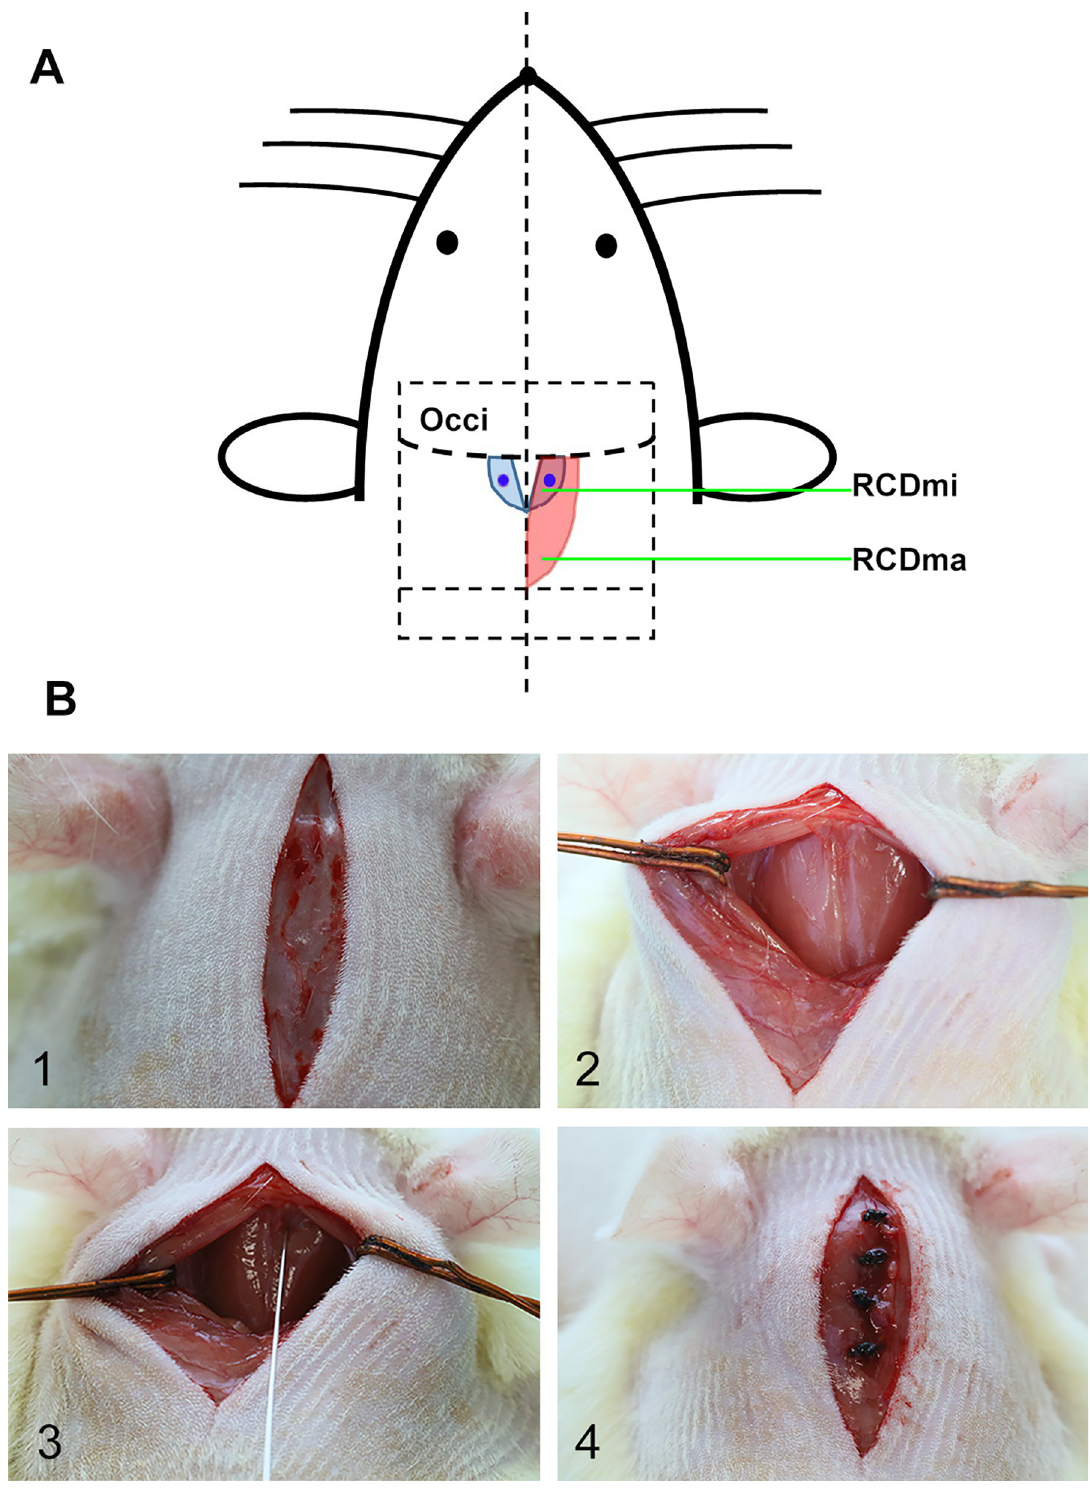
Fig 1. Surgical preparation and Ace-031 injections. A. modeling diagram of local injection; B. operation method: 1. prepare the skin of the surgical region and make a sagittal incision on the skin along the midline, 2. make a sagittal incision on the superficial layer of muscles to expose the RCDma muscles, 3. locate the injection site and inject, 4. suture the superficial layer of muslces and skin respectively. RCDma: rectus capitis dorsalis major; RCDmi: rectus capitis dorsalis minor; blue circle: injection site.